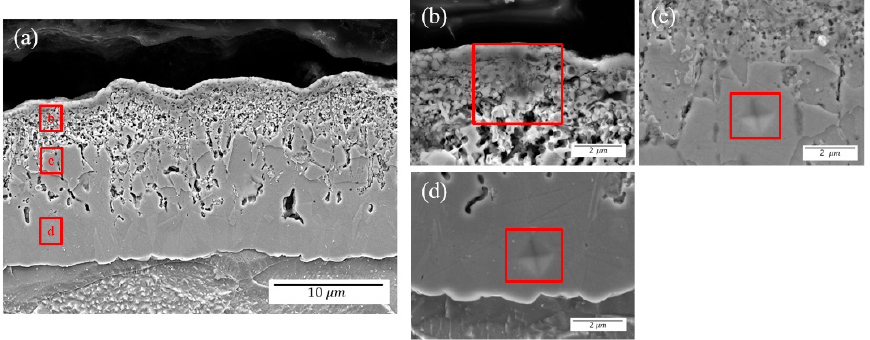
Figure 6. SEM image and impression of indenter on each phase after nanohardness test for steam-specimen: ( a ) SEM image; ( b ) magnetite; ( c ) epsilon; ( d ) gamma prime.